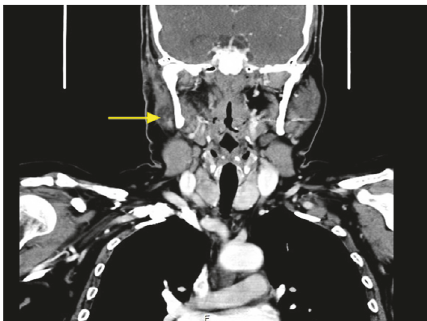
Figure 2: Coronal CT image demonstrates the residual parotid tumor (arrow), before the definitive surgery.